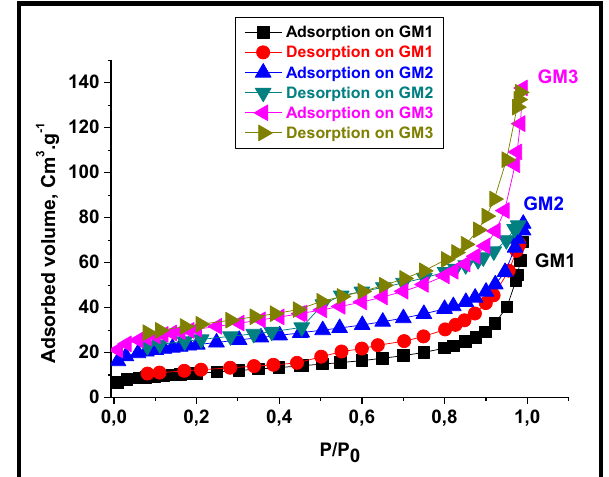
Figure 4: N 2 adsorption – desorption isotherm on GM1, GM2, and